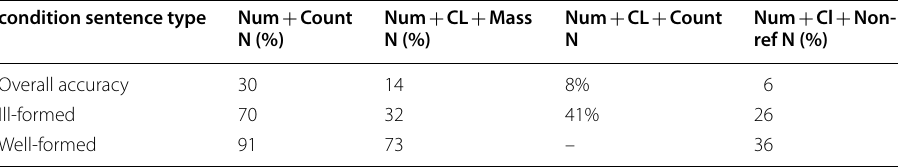
Table 6 Accuracy rates per sentence type for each condition condition sentence